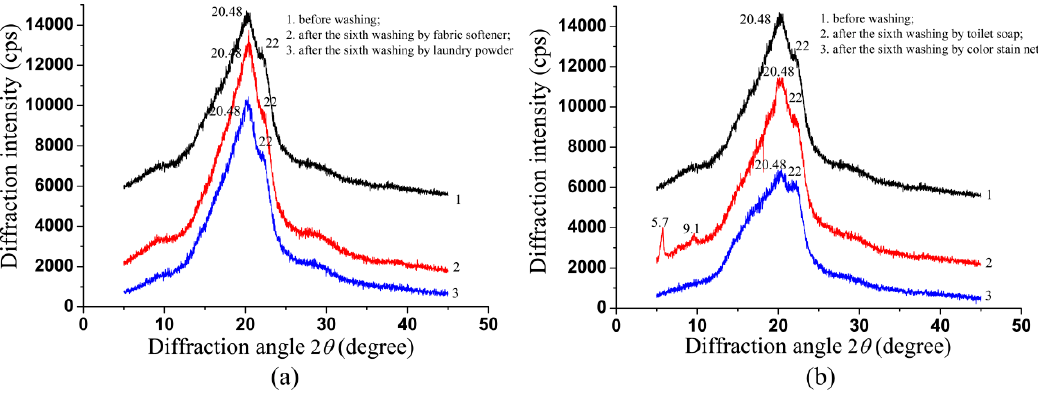
Figure 9. X-ray diffraction curves of silk samples. ( a ) 1. The silk before washing; 2. The silk after the sixth washing by fabric softener; 3. The silk after the sixth washing by laundry powder; ( b ) 1. The silk before washing; 2. The silk after the sixth washing by toilet soap; 3. The silk after the sixth washing by color stain net.